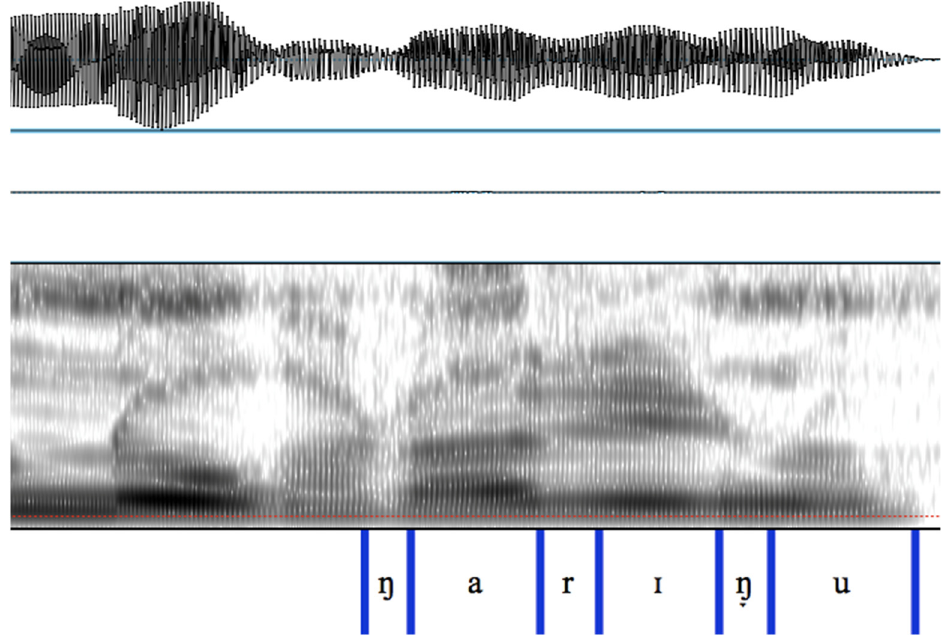
Figure 3. Example of approximation by older speaker UT ( ŋ ari- ŋ u ‘lie- PST ’) (Umatji_20181031).